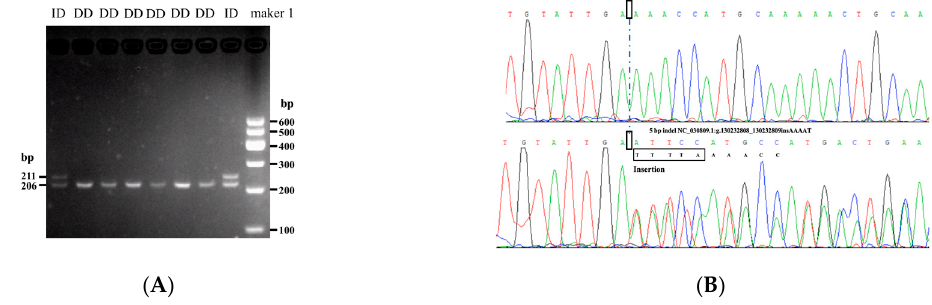
Figure 1. Agarose electrophoresis of MSTN 5 bp indel ( A ), and sequencing chromas for the 5 bp indel in the MSTN gene ( B ). Sequencing chromas showed homozygotic deletion type (DD) and heterozygote type (ID).